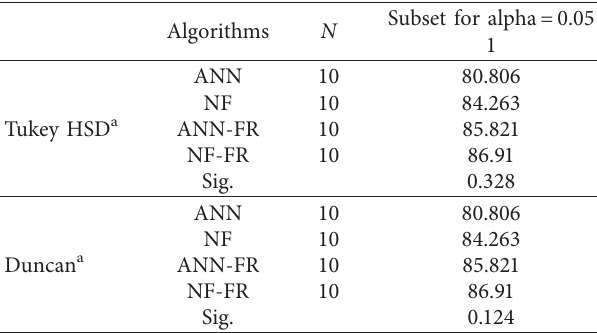
Table 9: Homogeneous group of models based on their level of significance.